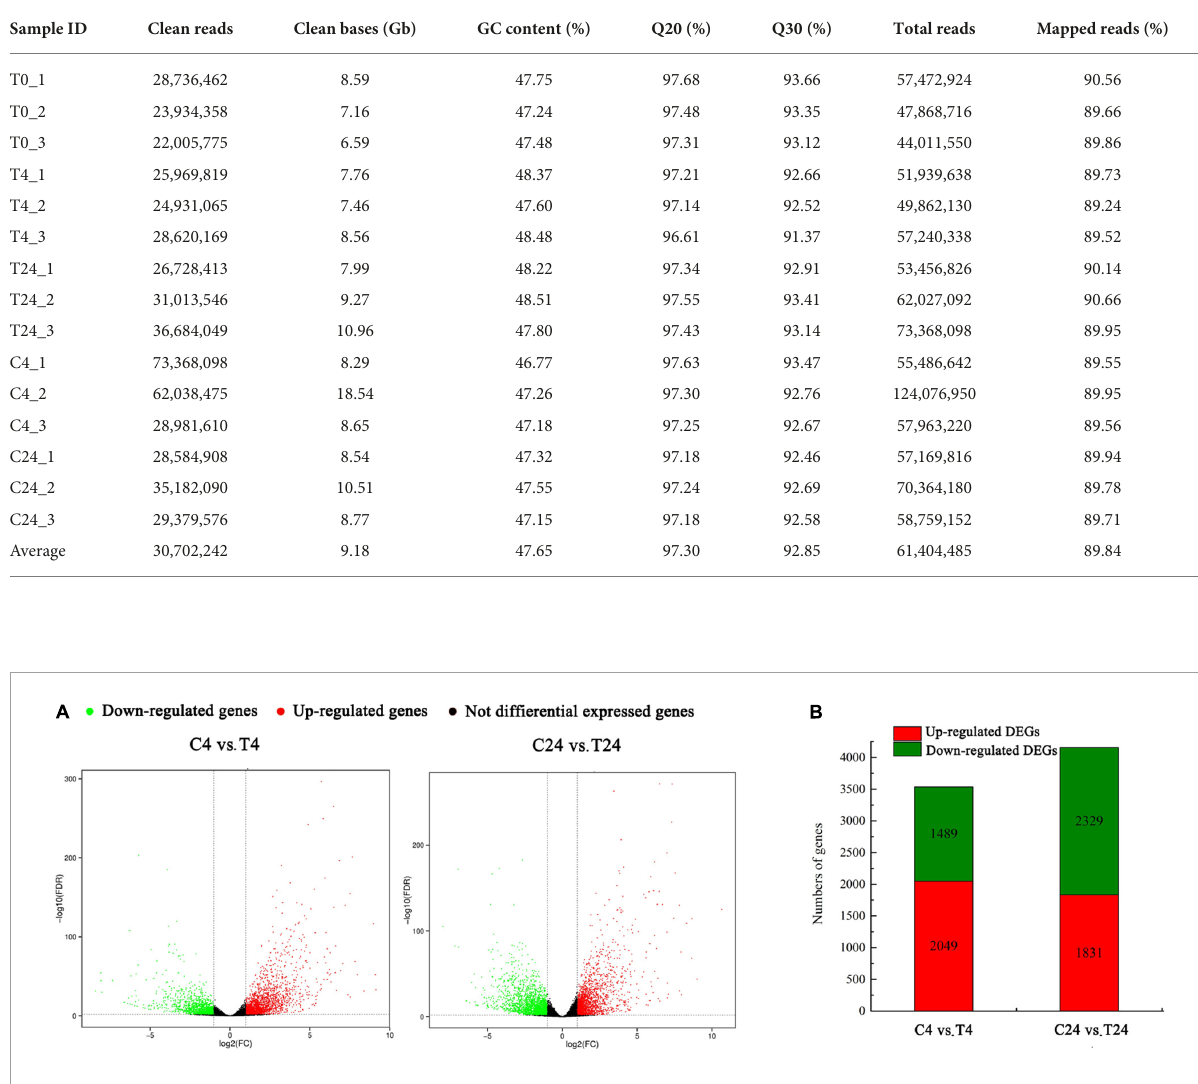
TABLE 1 Summary of the sequencing quality of 15 cDNA libraries of D. officinale .